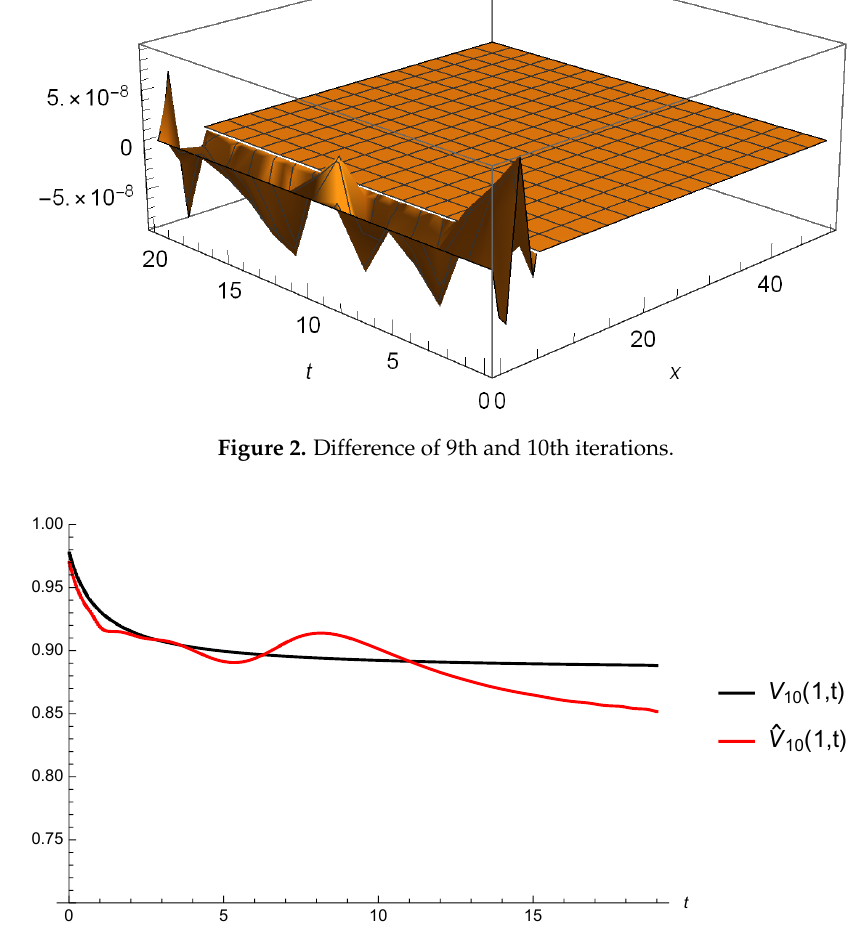
Figure 3. The hitting probabilities in x = 1—original and